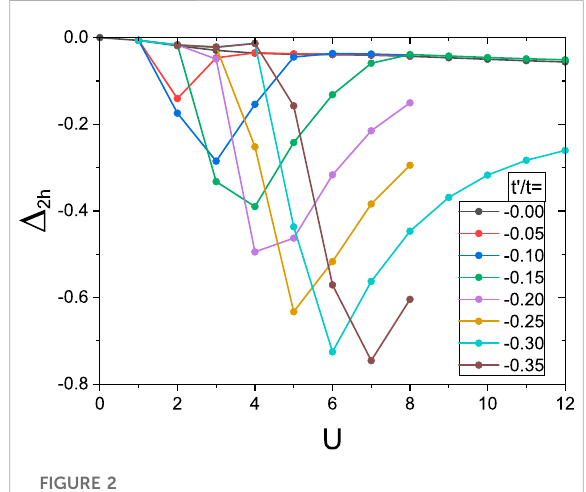
FIGURE 2 Pairingenergy Δ 2h oftwoholesina4×4clusterwithperiodic boundary condition as a function of U and t ′ . All energies are in units of t ≈ 0.35 eV. Reproduced with permission from